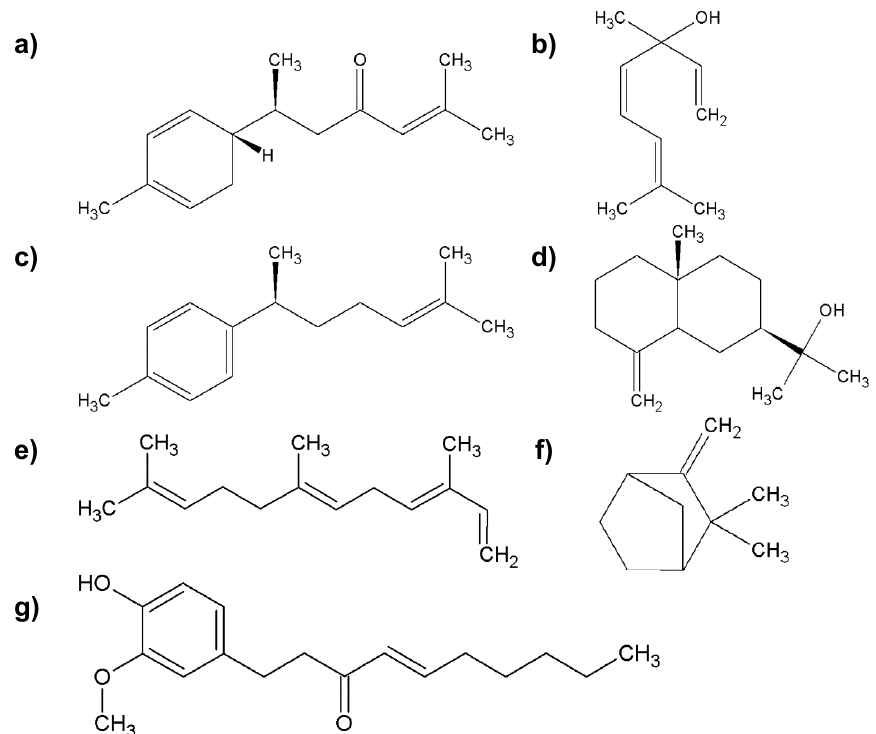
Figure 6. The most important group of chemicals found in ginger root; ( a ) α -zingiberene; ( b ) linalool; ( c ) ar-curcumene; ( d ) zingiberol; ( e ) α -farnezene; ( f ) camphene; ( g ) shogaol.